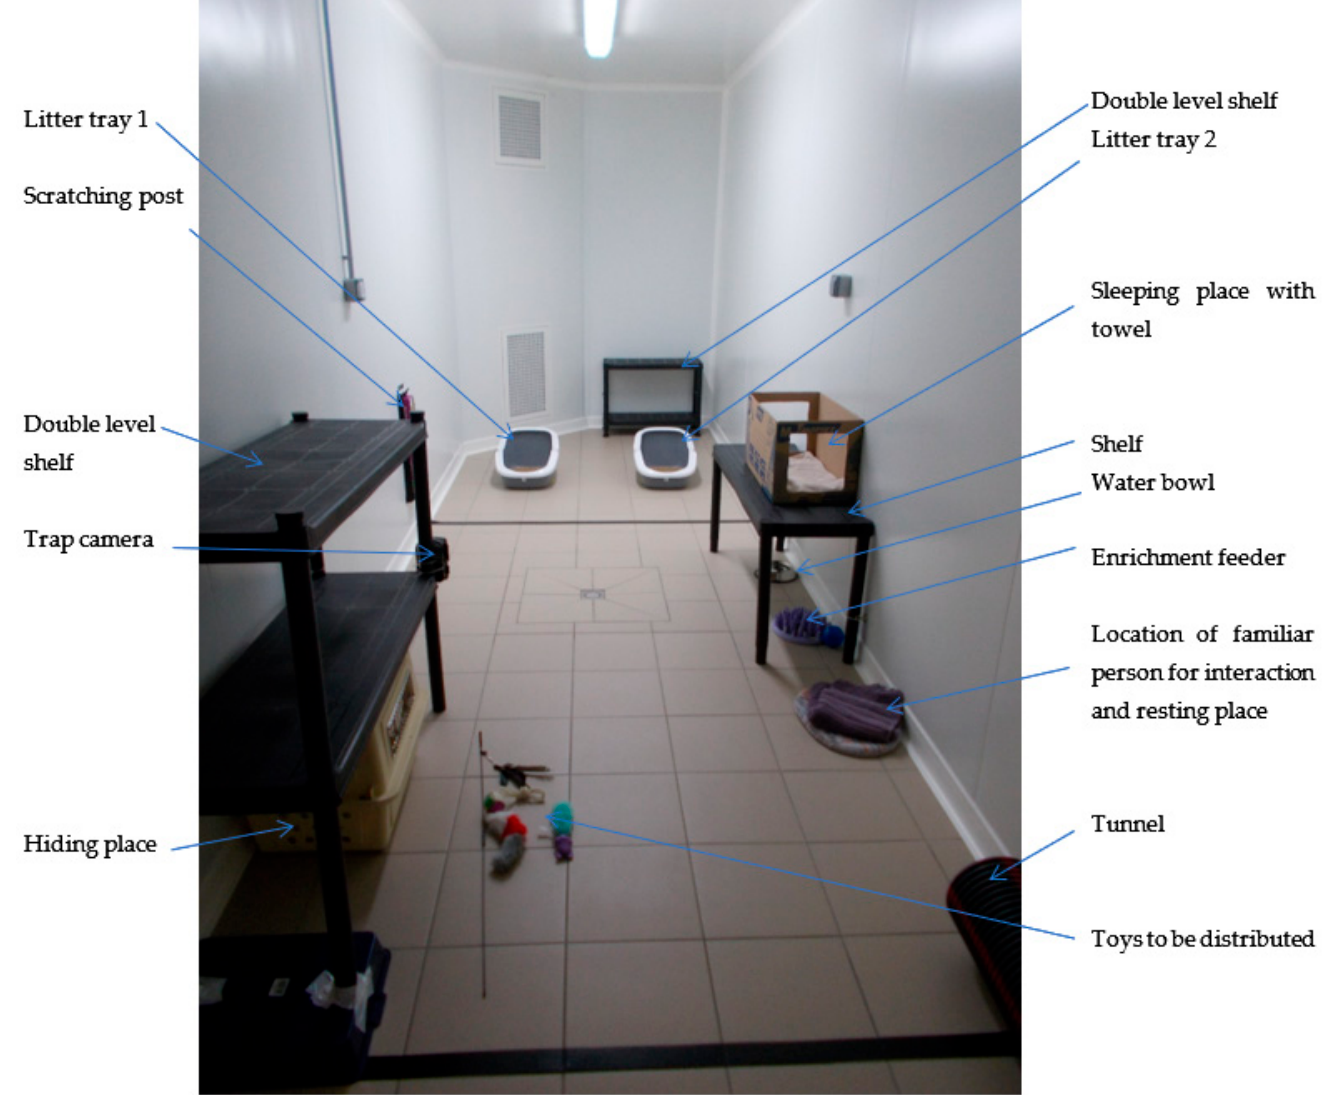
Figure 1. Enriched test